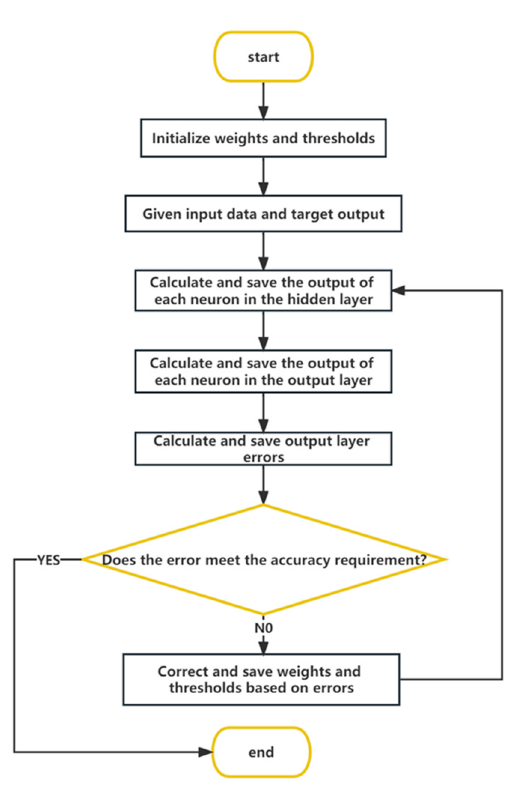
Figure 2. Flow chart of the BP neural network algorithm.